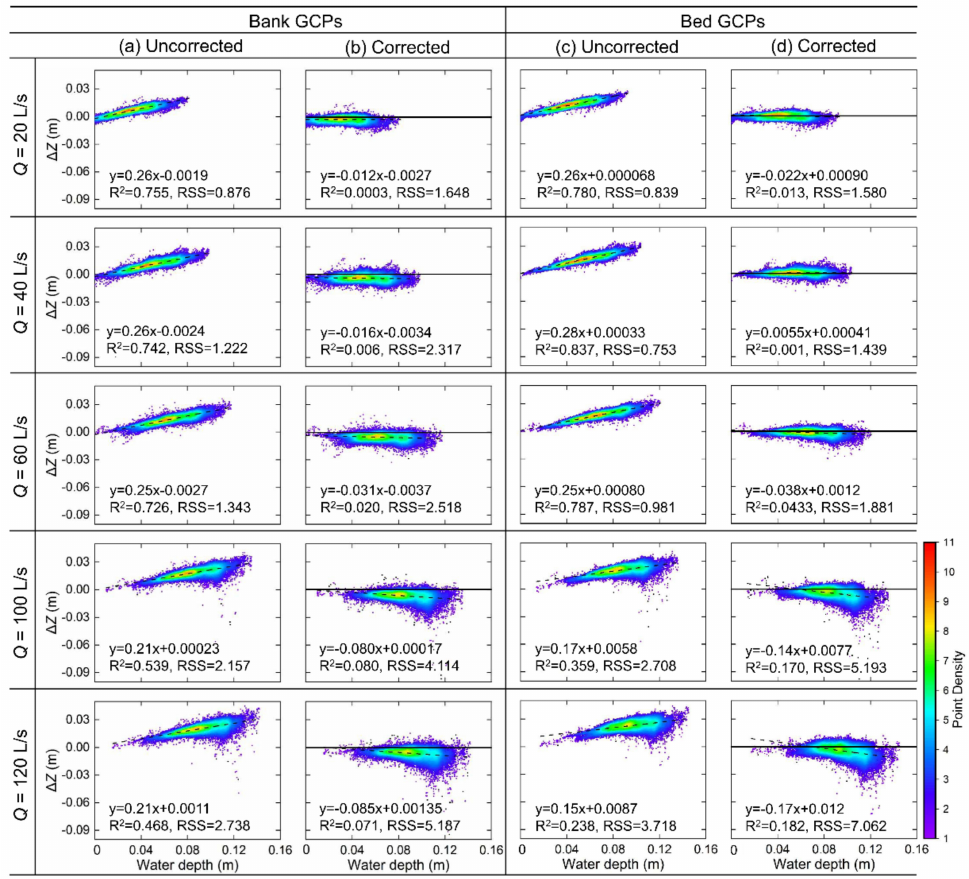
Figure 10. Relations between water depth and elevation error for MR2: ( a , b ) for the uncorrected and corrected models with the bank GCPs, respectively; ( c , d ) for the uncorrected and corrected models with the bed GCPs, respectively. Linear regression for each relation is presented with the regression equation, R-square, and residual sum of squares